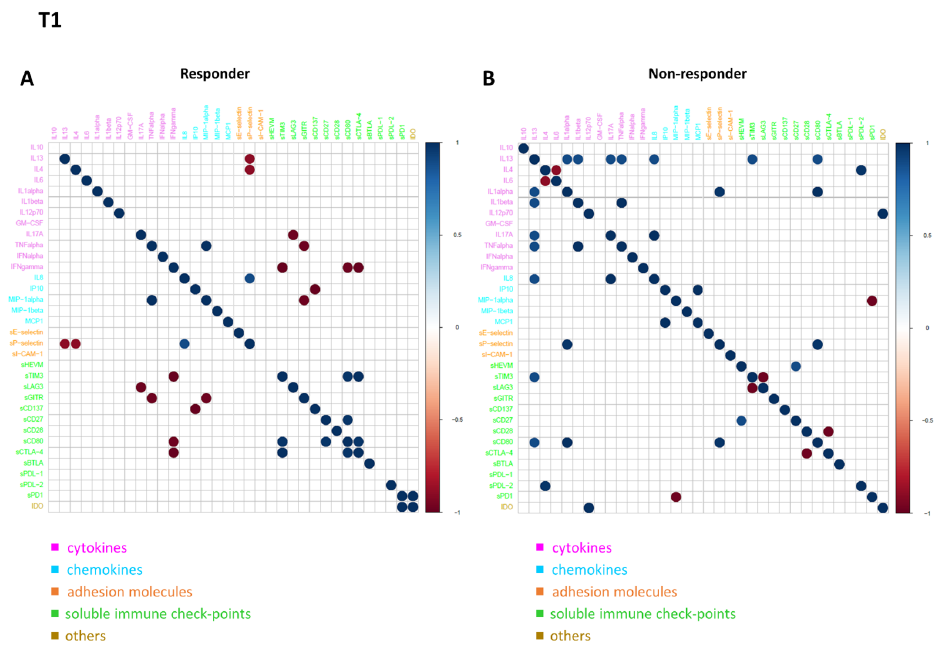
Figure 5. Connectivity map between molecules in responder ( A ) and non-responder ( B ) patients at T1. Statistically significant Spearman correlations ( p -value ≤ 0.05) are reported. In the plot, circles are scaled and colored according to the correlation values, increasing from red (negative correlation) to blue (positive correlation). Molecules are grouped and ordered according to the functional group reported in the legend.